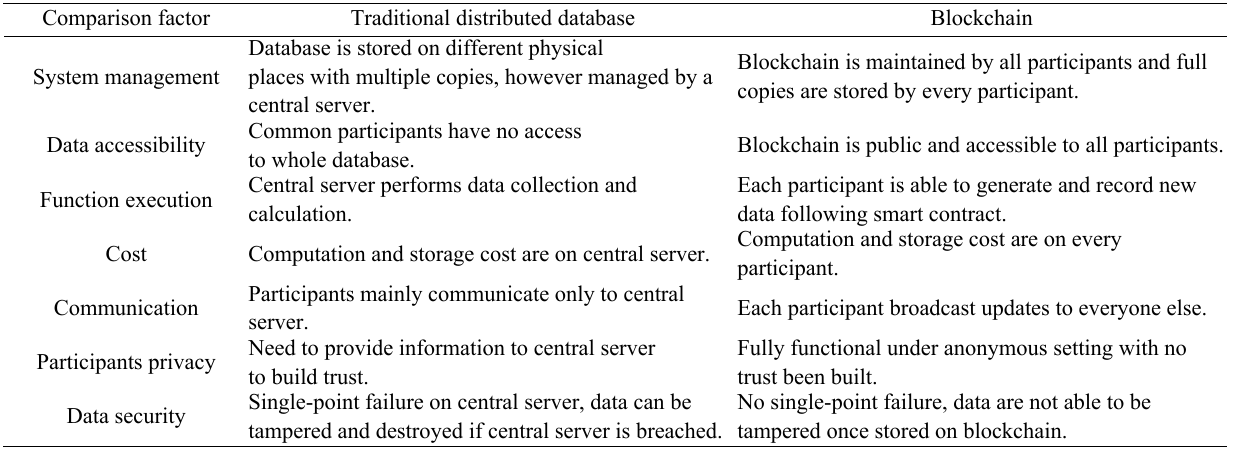
Table 1 Comparison between traditional distributed database storage and blockchain.